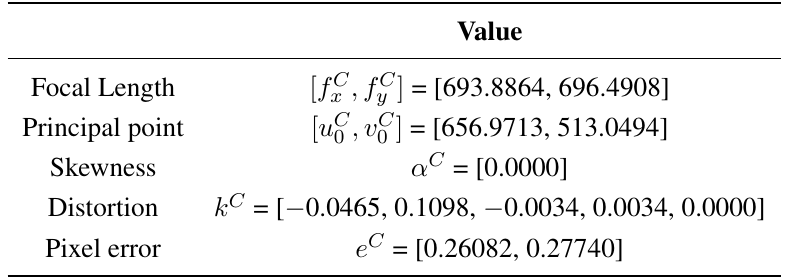
Figure 8. Camera’s intrinsic calibration results. The left side of the figure is the 3D geometric results of the checker board from the camera calibration, and the right side of the figure is the checker board images used for calibration. Table 2. Intrinsic parameter calibration results. The camera lens distortion k C is a vector containing tangential and radial distortion coefficients [36], and the camera pixel error e C denotes a vector of the standard deviation of the reprojection error along the u C and v C